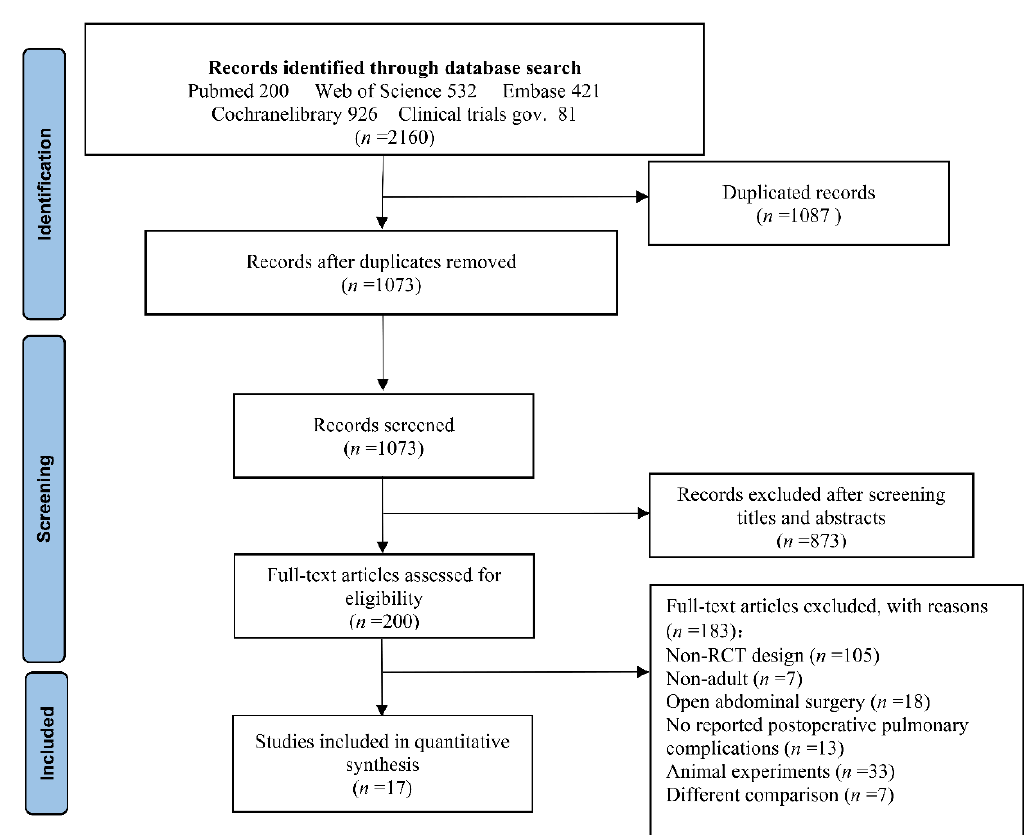
Figure 1. Flow chart of study screening.